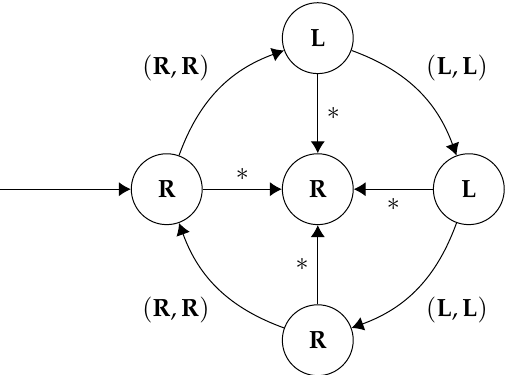
Figure 3. A finite memory strategy for player 1 which forms part of a Nash equilibrium which models the given specification. The asterisks * are wildcards—they match any action which isn’t explicitly detailed on the diagram.